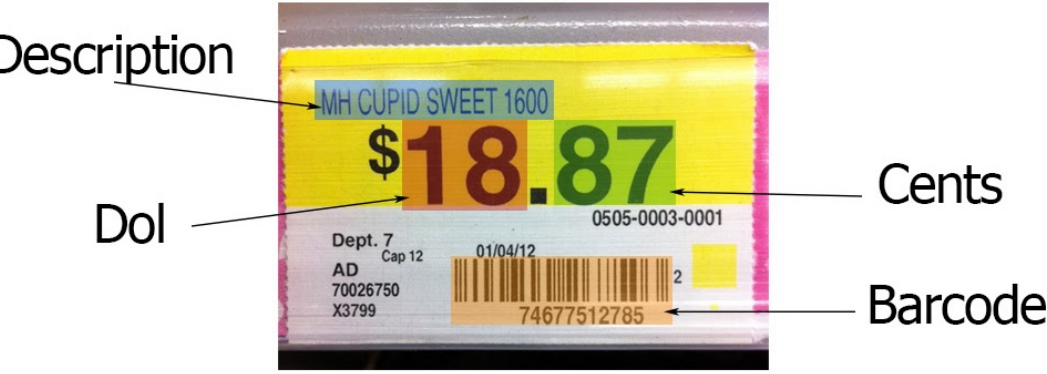
Figure 2. Walmart price tag labeling example.